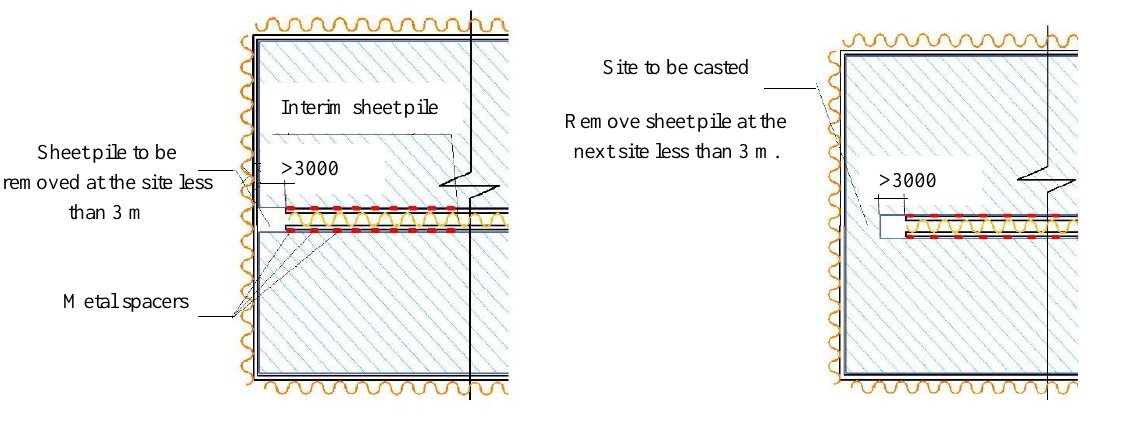
Figure 4. Schematic view of separate startup lines of two-level underground garages using metal